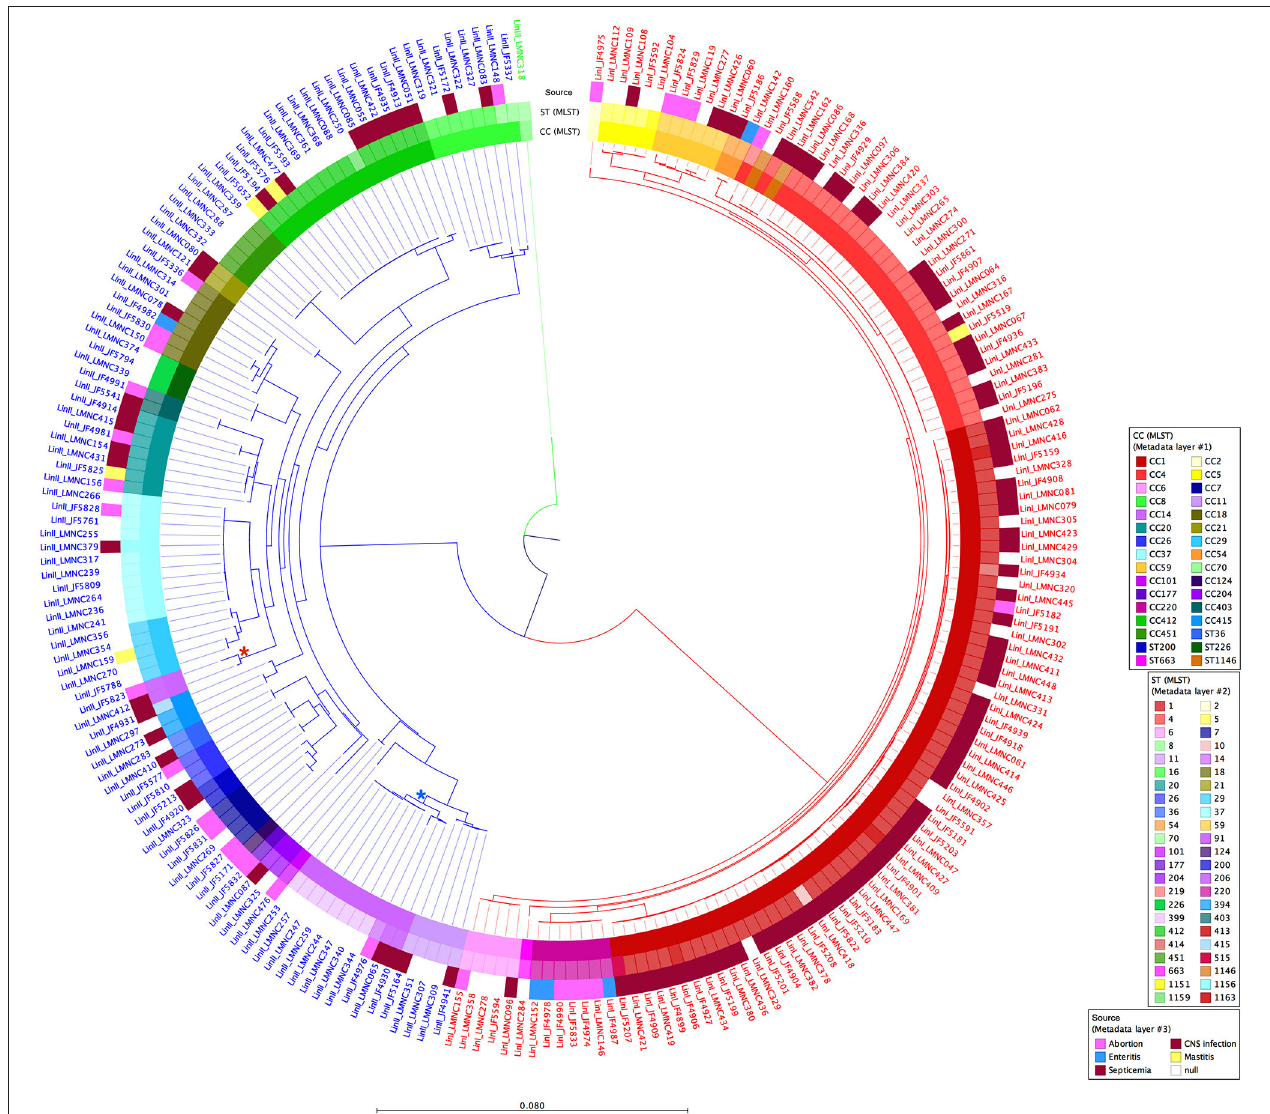
FIGURE 2 | Circular dendrogram of the phylogenetic tree obtained with RAxML (Stamatakis, 2014) based on the SNVs along the whole genome of all 225 strains from lineages I and II, taking the JF4839 strain from lineage II as a reference and the LMNC318 strain from lineage III as an outgroup. Branch colors correspond to different lineages: red, lineage I; blue, lineage II; green, lineage III. Metadata is also plotted in colors as concentric rings. From inside to outside: Clonal Complex (CC) classification, Sequence Type (ST) classification, and source of infection (white color indicates food/environmental strains). *Indicates the branch corresponding to ST91 (CC14), while *highlights the branch where the rest of CC14 strains are located. See Table S1 for details in CC, ST and source of infection. Distance bar represents the number of substitutions per